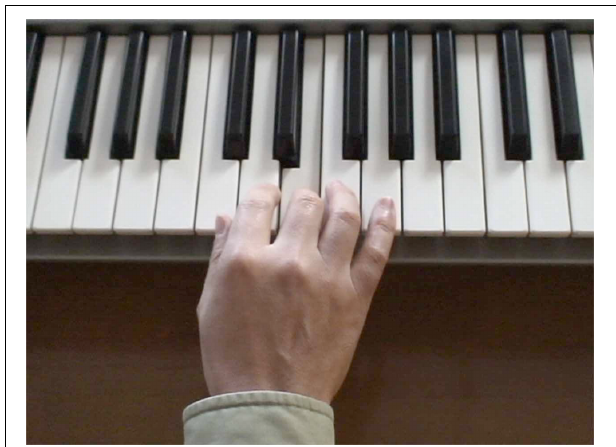
FIGURE 1 | Static example of a stimulus